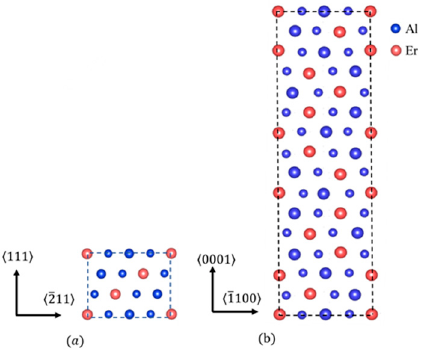
Figure 3. Side view of the stacking sequences for Al 3 Er with ( a ) Cu 3 Au.cP4 and ( b ) Al 3 Ho.hR20 structure.